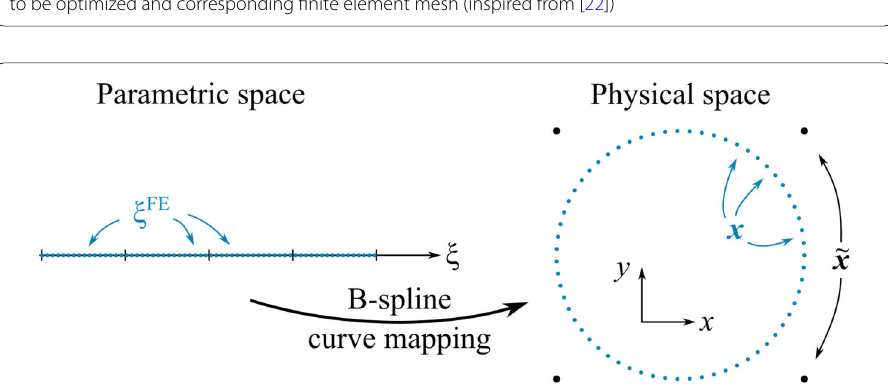
Fig. 9 Definition of the design space for the orthotropic specimen with two holes: 1D-FFD morphing box (left: parametric space; right: physical space) with its control points (black points) and position of the controlled FE nodes (blue